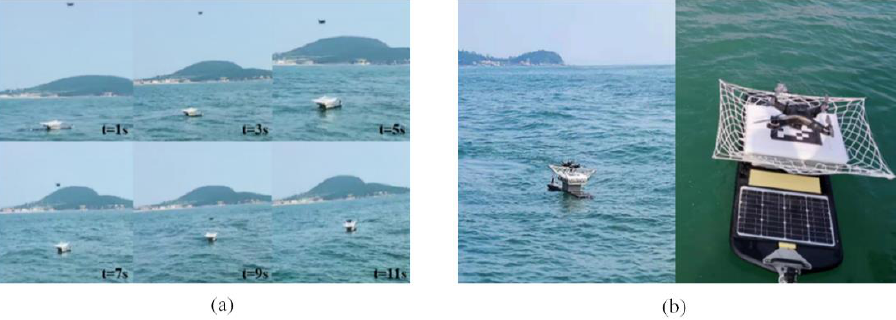
Figure 14. Sea trials. ( a ) Dynamic landing of quadrotor on the sea; and ( b ) equipment recycling picture.